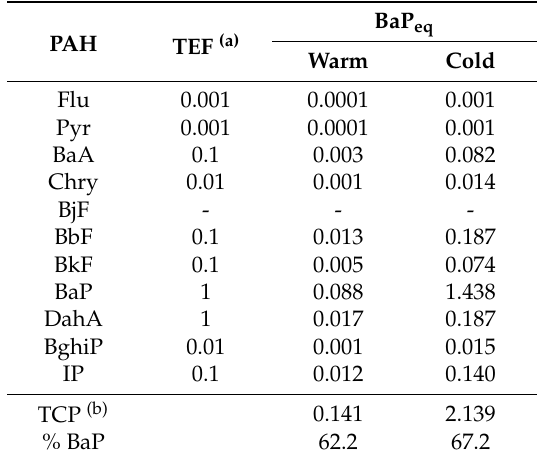
Table 4. Equivalent BaP eq (ng m − 3 ) concentrations for individual PAHs measured during the warm and cold period. BaP eq PAH TEF (a)